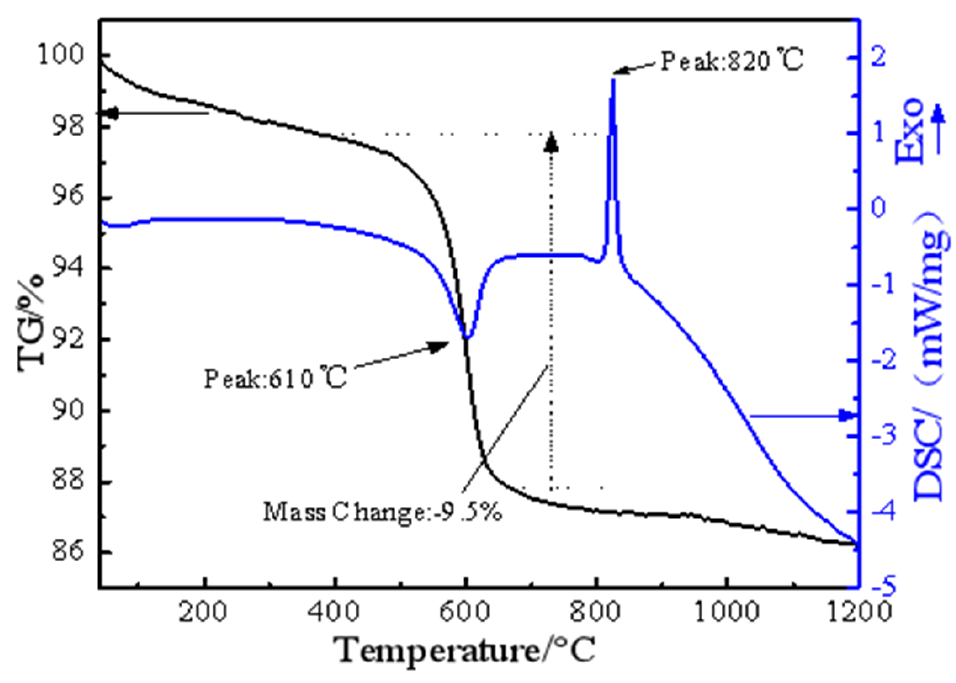
Figure 4. TG/DSC curves for thermal decomposition of the raw garnierite ore.